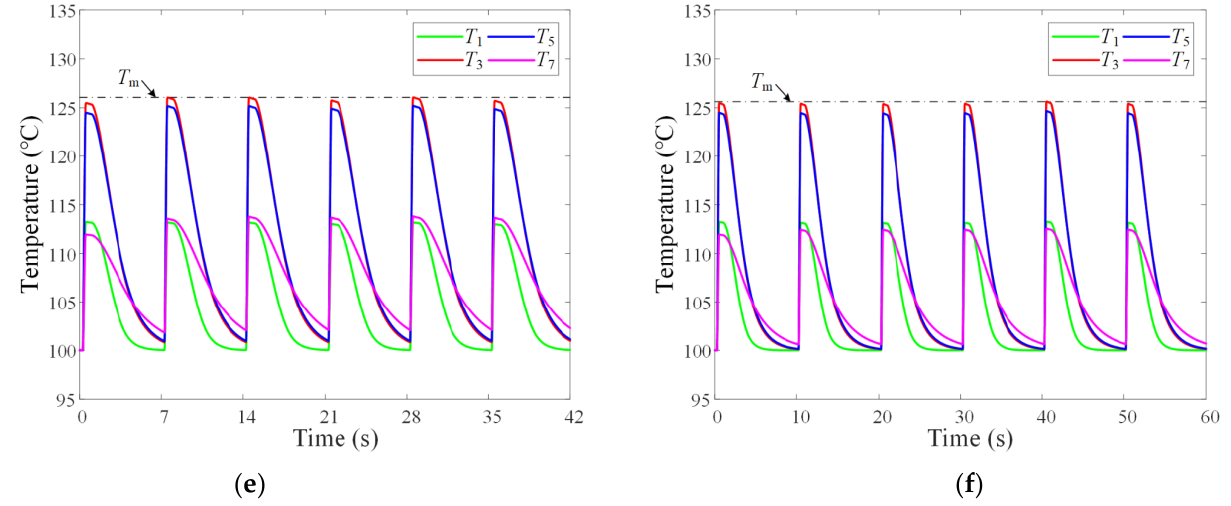
Figure 7. Variation of temperatures at different shifting intervals: ( a ) 2 s; ( b ) 3 s; ( c ) 5 s; ( d ) 6 s; ( e ) 7 s; ( f ) 10 s.